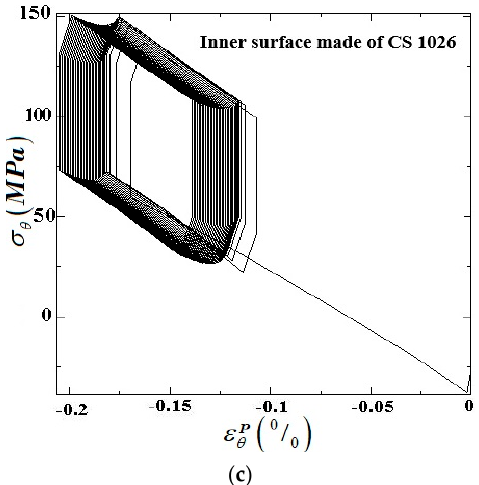
Figure 6. Representative stress–plastic strain hysteresis loops in the hoop direction of FGM pipe with the inner surfaces made of CS 1026 under sustained internal pressure plus cyclic bending loading for different types of elastic–plastic behaviors. ( a ) elastic shakedown under P in = 0.33 P y and M = 1.85 M y ; ( b ) plastic shakedown under P in = 0.24 P y and M = 2.75 M y ; ( c ) ratcheting under P in = 0.94 P y and M = 3.8 M y .